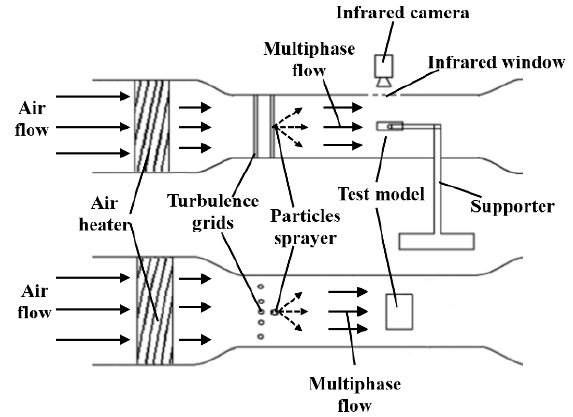
Figure 1. Experimental system schematic.